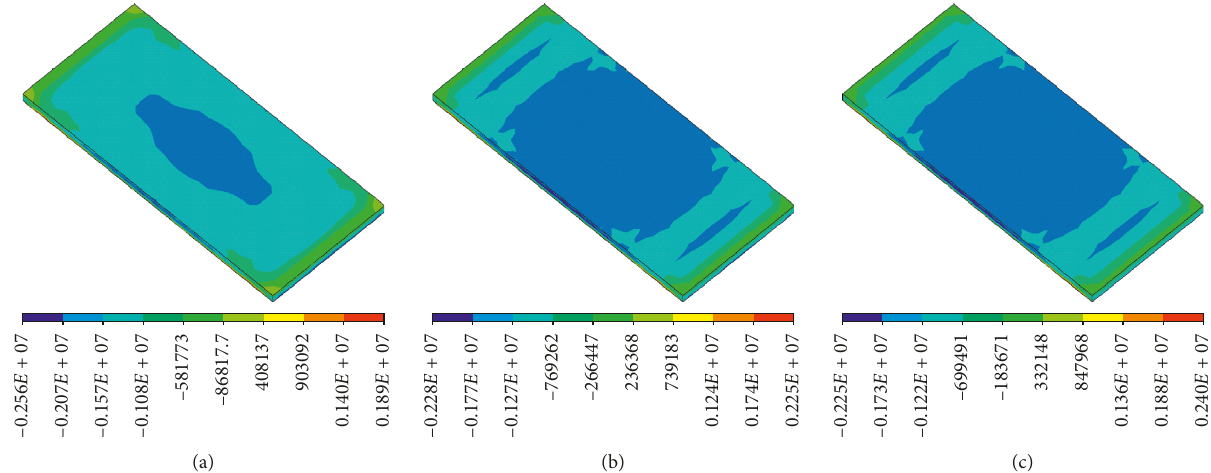
Figure 16: Longitudinal stress of the self-compacting concrete layer under condition 2. (a) P